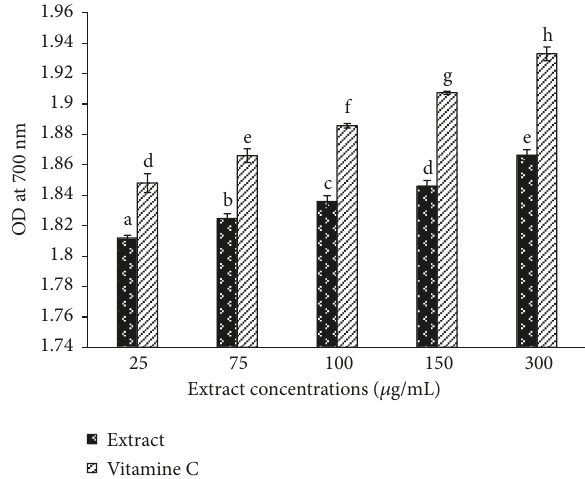
Figure 3: Reductive power of the water-ethanol extract of Tetrapleura tetraptera. Values are expressed as mean ± SD of three replicates. In the same concentration the values affected with different letter are significantly different at p < 0.05. Extract: water-ethanol extract of Tetrapleura tetraptera